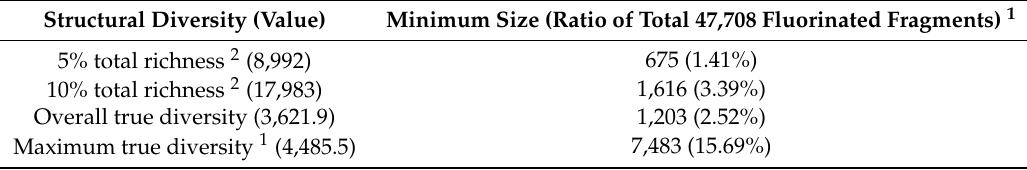
Table 2. Fluorinated library sizes (diversity-based selection) required to achieve certain values of structural